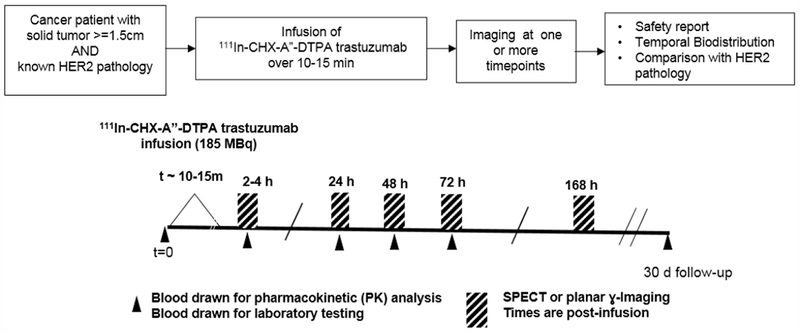
Protocol schematic